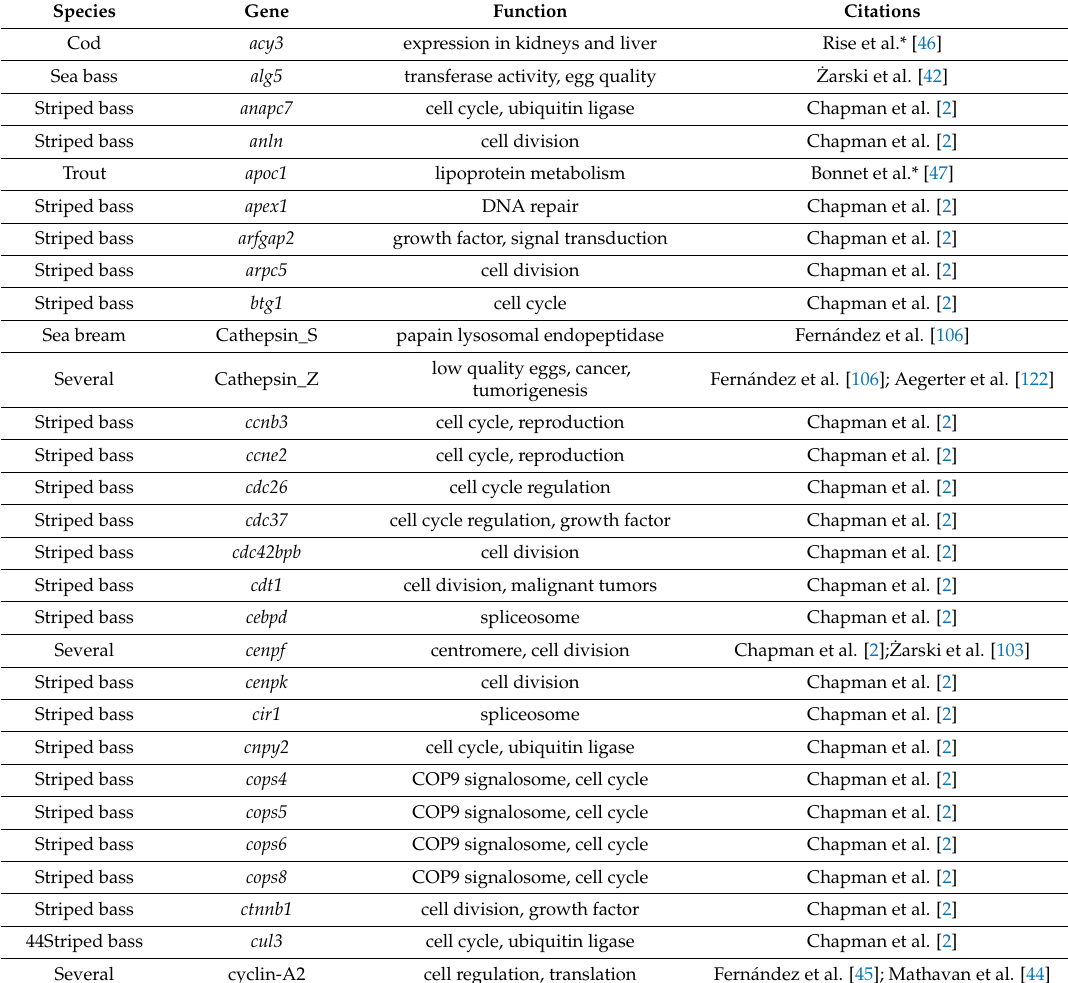
Table 1. Genes involved in egg quality of